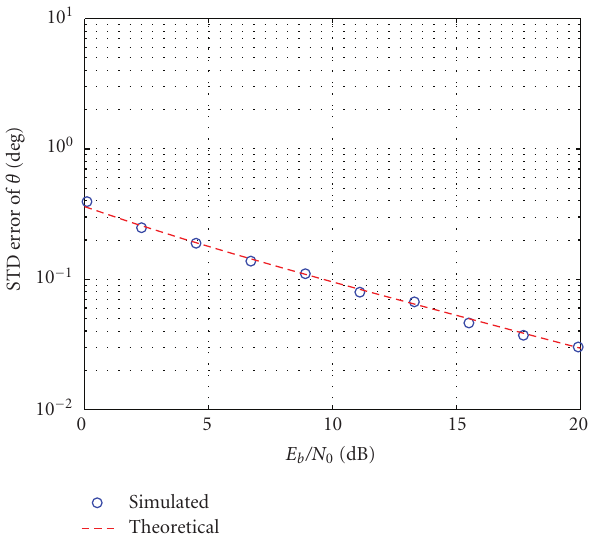
Figure 11: Standard deviation of DOA estimation error (stationary tag, M =